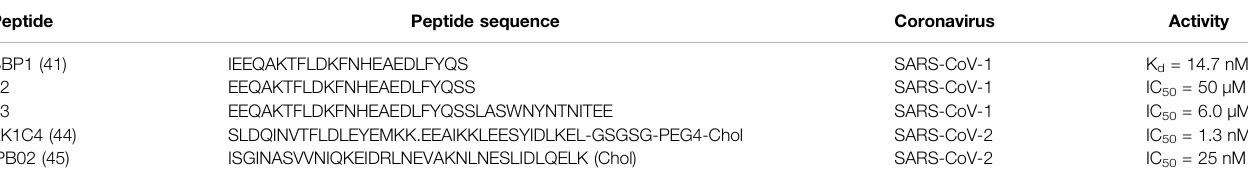
TABLE 5 | Peptide inhibitors targeting the S protein. Peptide Peptide sequence Coronavirus Activity SBP1